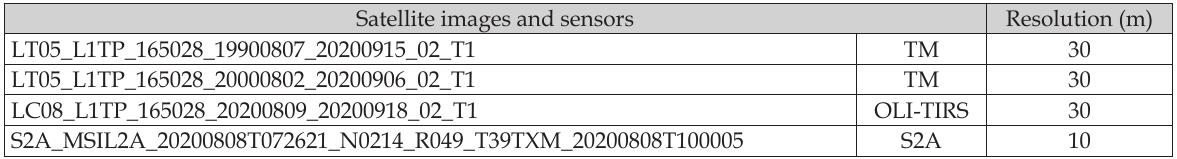
Table 1. Summary of the datasets used: Satellite images and their sensors with resolutions. Satellite images and